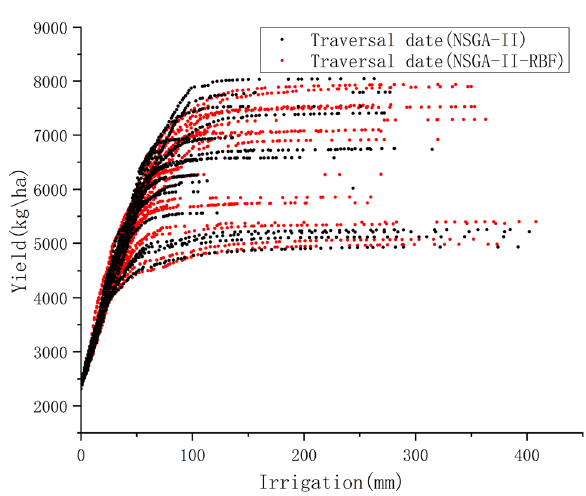
Figure 6. Comparison of traditional optimization algorithm for traversing irrigation dates and application of surrogate optimization for traversing irrigation dates.